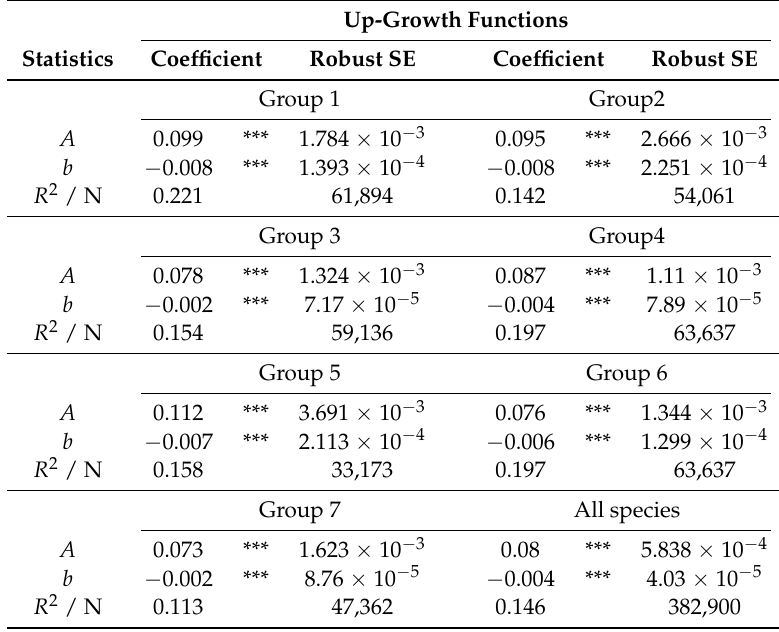
Table 4. Parameters of the up-growth probability functions by group of species ( 1 )